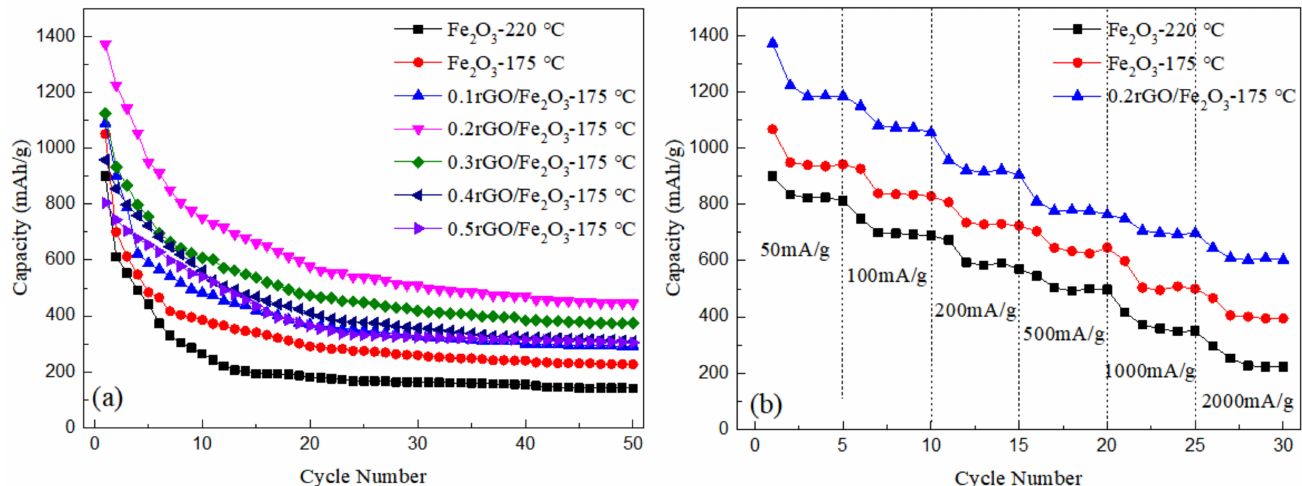
Figure 5. ( a ) Constant current discharge curves of Fe 2 O 3 and rGO/Fe 2 O 3 -175 ◦ C with differ- ent graphene ratios at a current density of 100 mA · g − 1 ; ( b ) Rate performance of Fe 2 O 3 -220 ◦ C, Fe 2 O 3 -175 ◦ C and 0.2rGO/Fe 2 O 3 -175 ◦ C at different current densities.